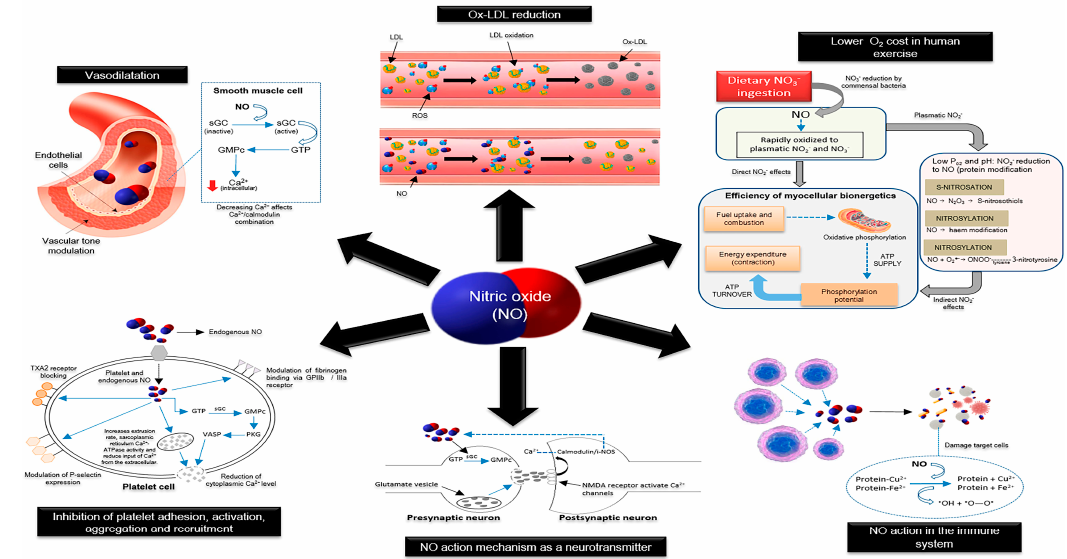
Figure 3. The physiological role of nitric oxide in smooth muscle tissue, maintenance of vascular tone, synaptic transmission, cellular defense, hemostatic-thrombotic balance, and mitochondrial function. ATP, adenosine triphosphate; ATPase, adenosine triphosphatase; Ca 2+ , calcium; Cu 2+ , copper; Fe 2+ , ferrous iron; GMPc, guanosine monophosphate cyclic; GPIIb, glycoprotein IIb; GPIIIa, glycoprotein IIIa; GTP, guanosine-5 ′ -triphosphate; iNOS, inducible nitric oxide synthase; LDL, low-density lipoprotein; N2O3, dinitrogen trioxide; NMDA, N-methyl-D-aspartate; NO, nitric oxide; NO 2 − , nitrite; NO 3 − , nitrate; O 2 , oxygen; ONOO - , peroxynitrite; Ox-LDL, oxidized low-density lipoprotein; PKG, protein kinase G; P O2 , pressure of oxygen; ROS, reactive oxygen species; sGC, soluble guanylate cyclase; TXA2, thromboxane A2; VASP, vasodilator-stimulated